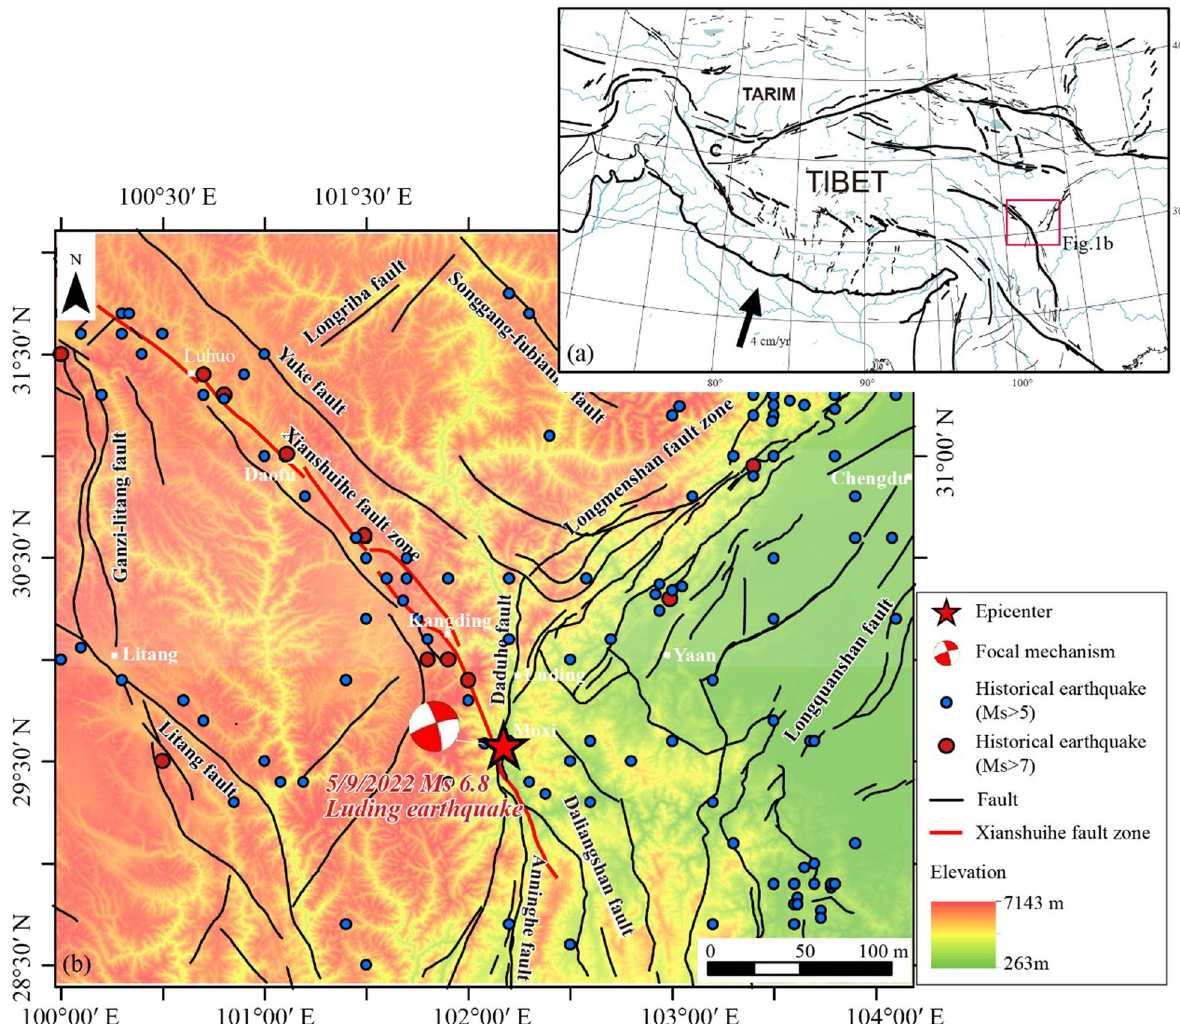
Fig. 1 Regional tectonic background and historical earthquake distribution map of Ms6.8 Luding earthquake on September 5, 2022. a Structural background of the Qinghai Tibet Plateau and its adjacent areas. b Tectonic background and historical earthquake distribution map of the seismic